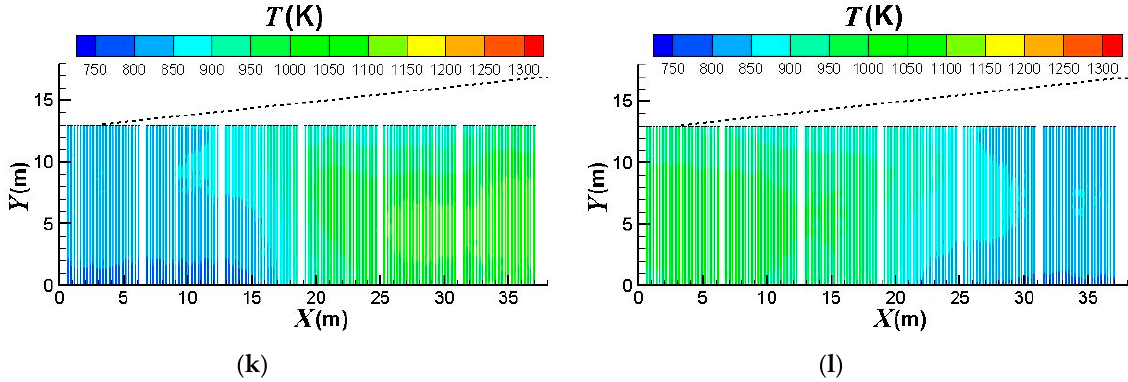
Figure 7. Outer surface temperature distributions of the catalyst tubes using different burners on/off combinations: ( a ) Fully opened; ( b ) Group 1 turned off; ( c ) Group 2 turned off; ( d ) Group 3 turned off; ( e ) Group 4 turned off; ( f ) Group 5 turned off; ( g ) Group 6 turned off; ( h ) Group 1 & 2 turned off; ( i ) Group 3 & 4 turned off; ( j ) Group 5 & 6 turned off; ( k ) Group 1, 2 & 3 turned; ( l ) Group 4, 5 & 6 turned off.